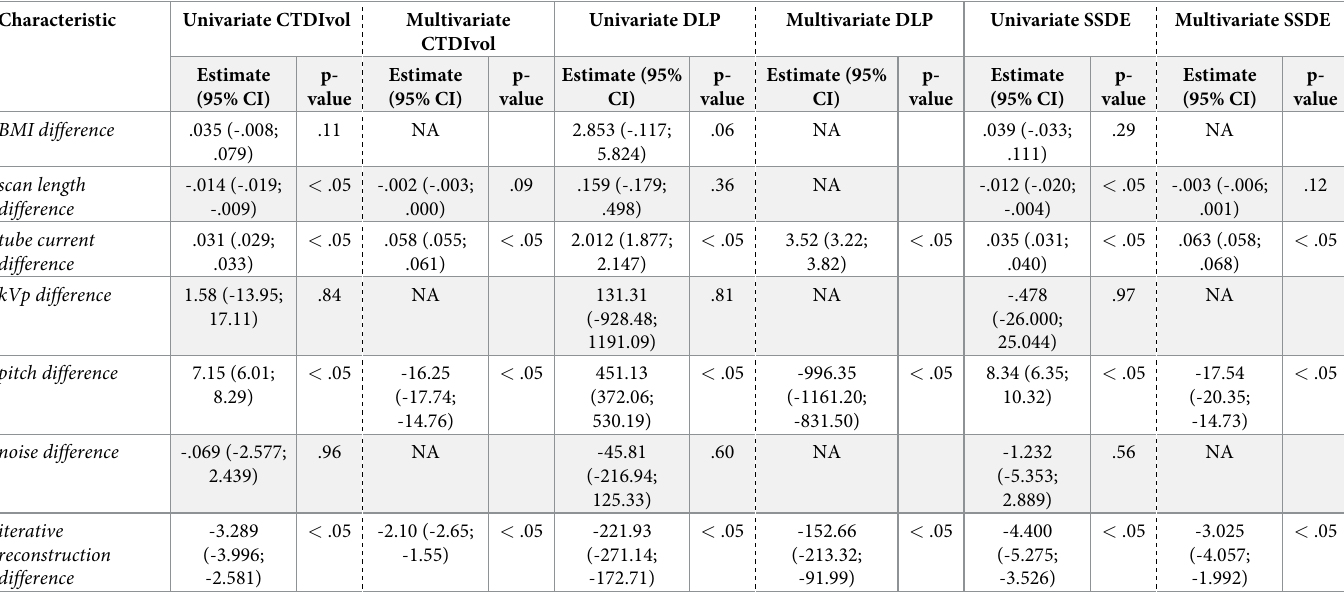
Table 4. Results of intraindividual analysis for the CT scans of the thoracoabdominopelvic region for the dose estimate parameter CTDIvol, DLP und SSDE.